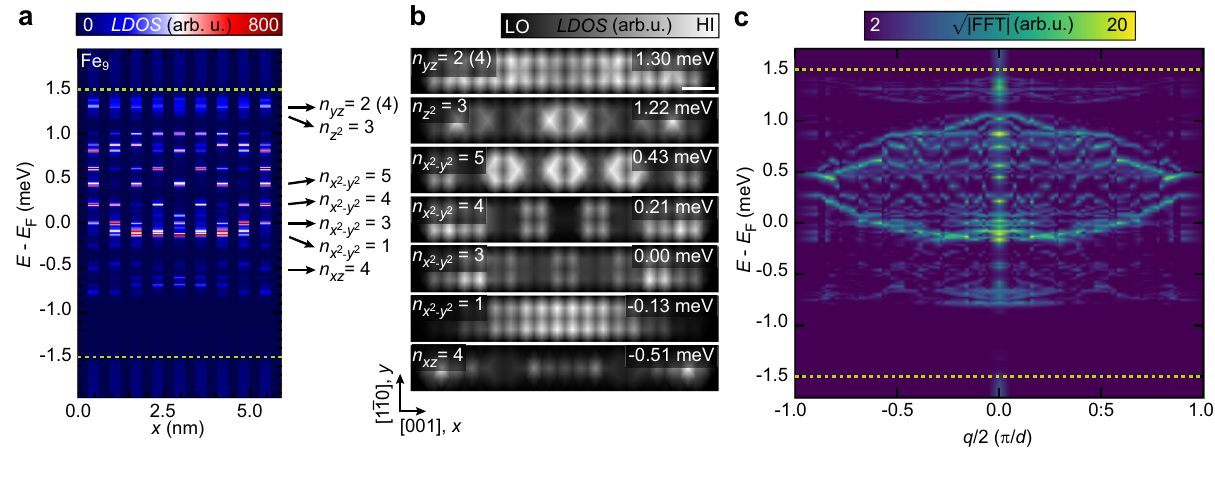
Figure 4 Calculated dispersion of Bogoliubov-de Gennes (BdG) quasiparticles in ferromagnetic Fe chains on Au monolayer. a Electron component of the local density of states (LDOS, given in arbitrary units, arb. u.) extracted along the longitudinal axis ( x ) of a ferromagnetic Fe 9 2 a − [001] chain, calculated on the Fe and the vacuum sites in between. b Spatial distributions of the LDOS evaluated in the fi rst vacuum layer above the chain. Energies are indicated in the top right corners of each panel, while the numbers of maxima and the orbital origins of the states are indicated in the top left corners. They correspond to the states marked by the same arrows and numbers in ( a ). The n yz state has two dominant Fourier components n yz = 2 and n yz = 4, where the former is dominating. The white scale bar has a length of 2 a . c Dispersion of scattering wave vectors extracted by the one-dimensional fast Fourier transforms (1D-FFT) from the calculated LDOSs of ferromagnetically coupled Fe N 2 a − [001] chains and averaged for lengths N of 9, 11, 13, 14, 17 and 19 atoms (Supplementary Fig. 7). The green dashed lines in panels ( a and c ) indicate the energy gap of the superconducting